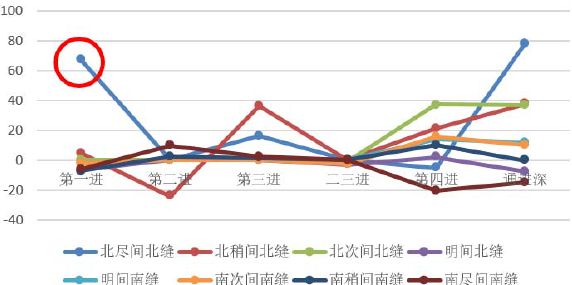
Fig.5 Coordinate of the top center of the column is